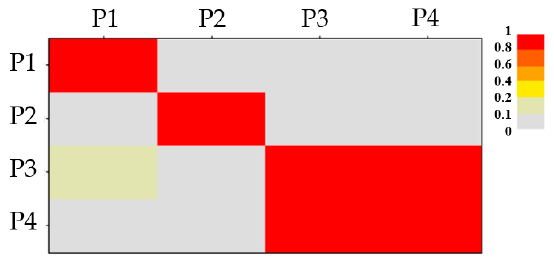
Figure 11. Correlation matrix diagram.